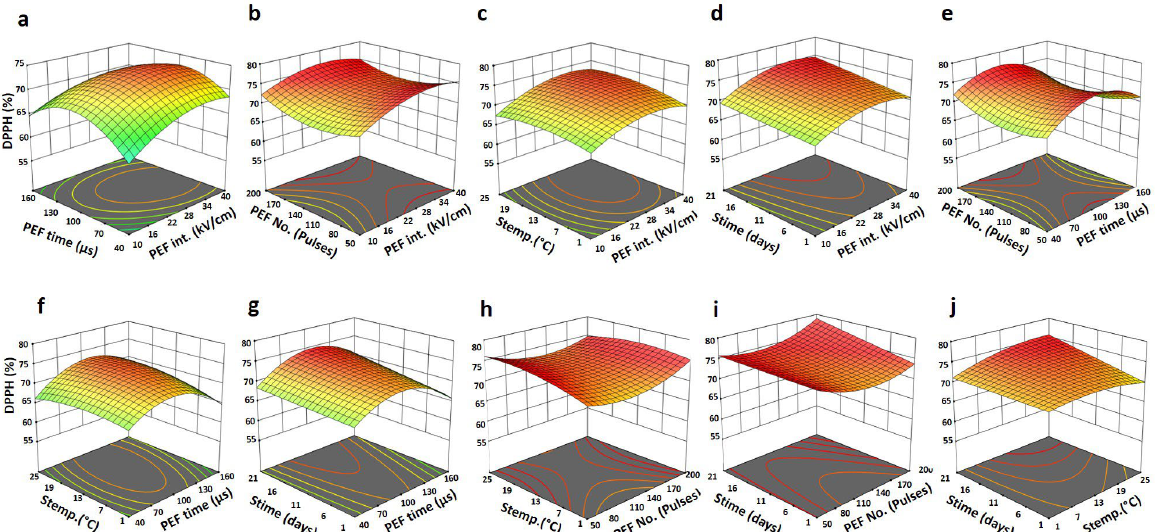
Figure 7. Response surface plots of antioxidant activity (DPPH inhibition, %) of Barhi dates as a function of PEF time and PEF intensity ( a ), PEF number of pluses and PEF intensity ( b ), storage temperature and PEF intensity ( c ), storage time and PEF intensity ( d ), PEF number of pulses and PEF time ( e ), storage temperature and PEF time ( f ), storage time and PEF time ( g ), storage temperature and PEF number of pulses ( h ), storage time and PEF number of pulses ( i ), and storage time and storage temperature ( j ).